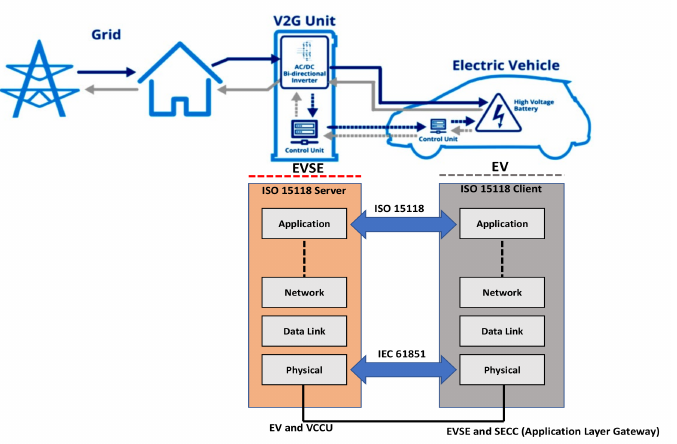
Figure 1. EV charging and V2G architecture with relevant communication standards